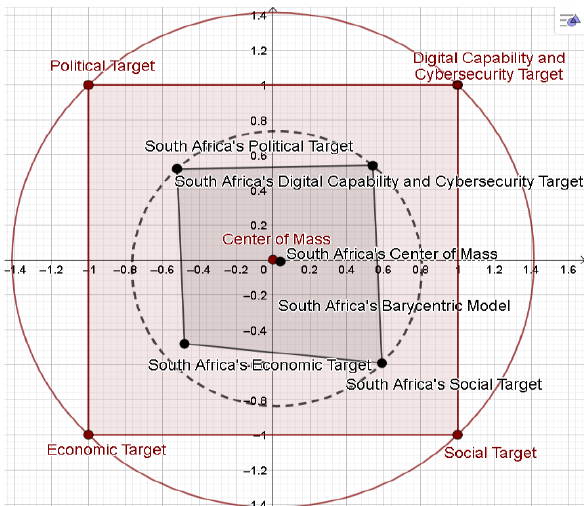
Figure 13. Four–pole barycentric model of balanced development of South Africa. Source: Authors’